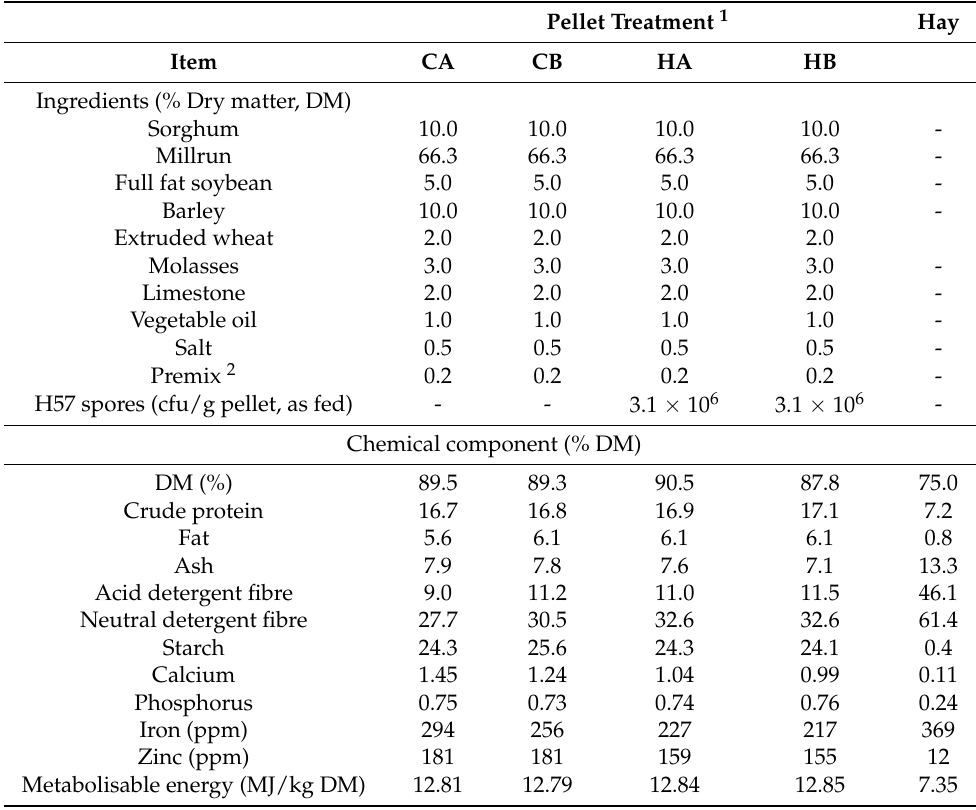
Table 1. The ingredients and chemical composition of the pelleted treatments and the oaten hay offered ad libitum in a group feeder as the background diet. Pellet Treatment 1 Hay Item CA CB HA HB